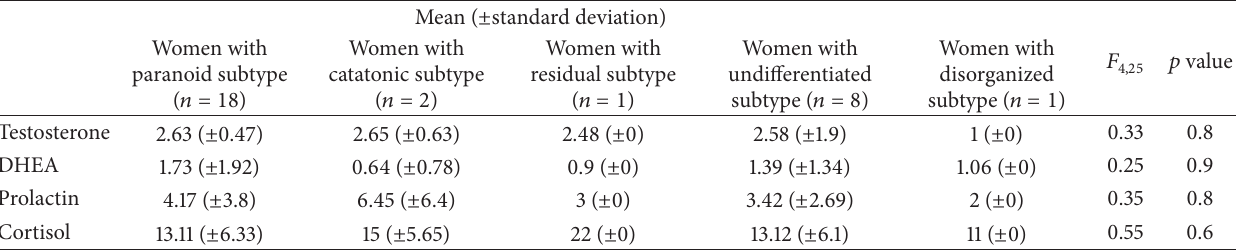
Table 4: Comparison using one-way analysis of variance of serum hormones levels in women with different subtypes of schizophrenia disorder. Mean ( ± standard deviation)